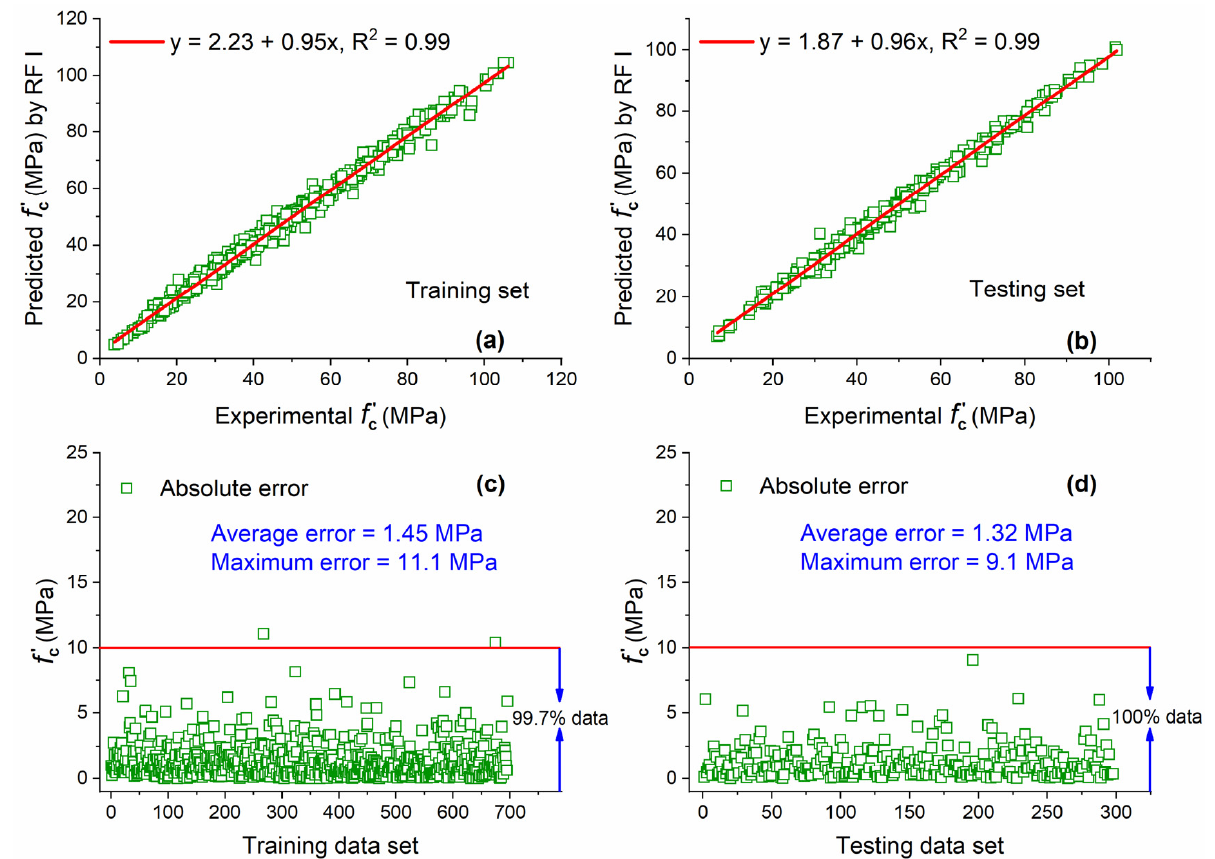
Figure 9. Experimental and predicted values of f (cid:48) by RF I for ( a ) training set and ( b ) testing set, and their corresponding absolute error for ( c ) training data set and ( d ) testing data set. Table 4. Statistical evaluation of GEP I, ANN I, and RF